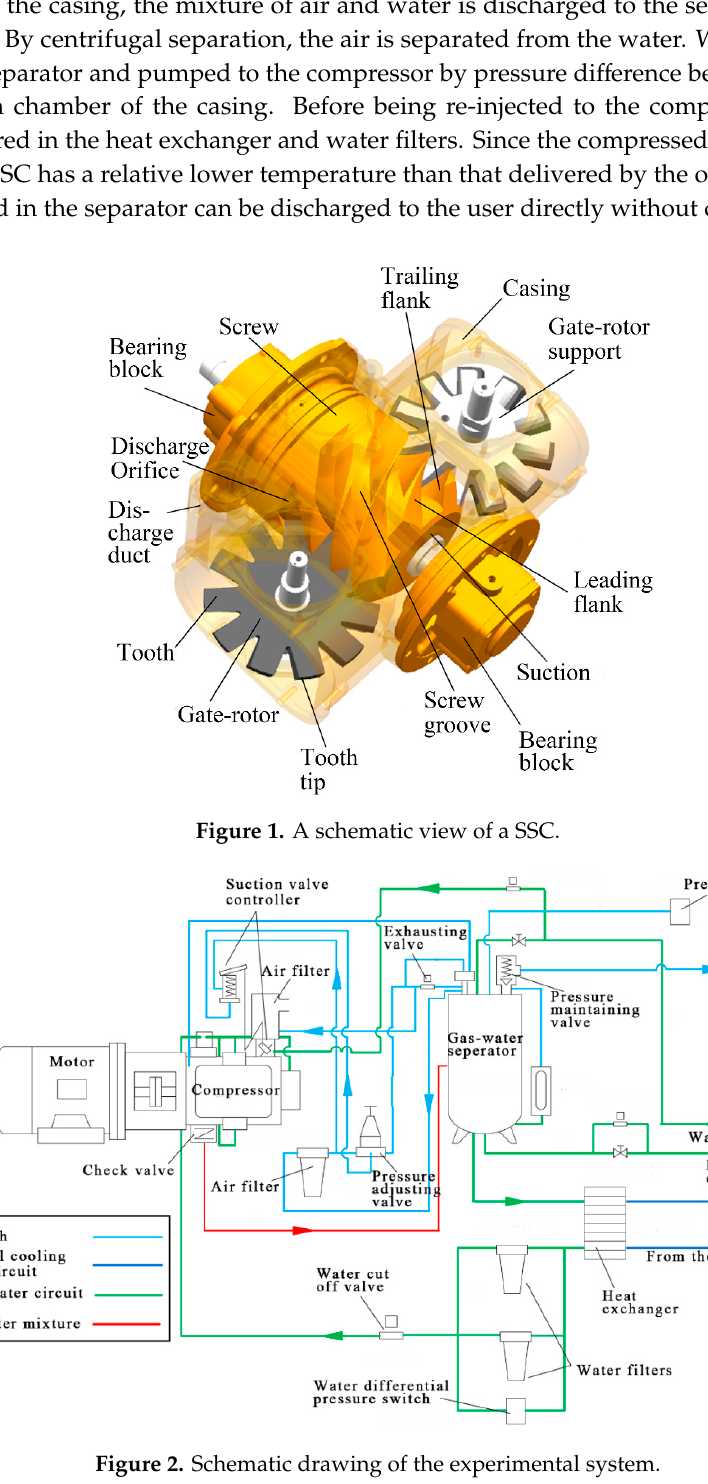
Figure 2. Schematic drawing of the experimental system.